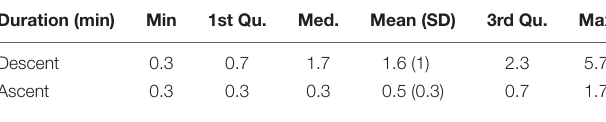
TABLE 4 | Duration (min) of continuous gliding bouts during descent and